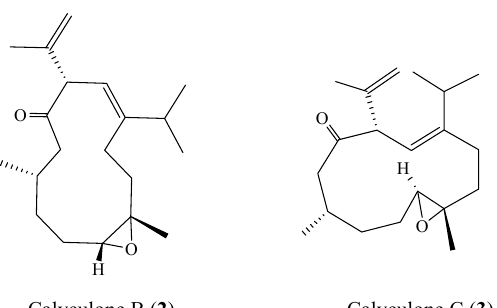
Figure 4. Structures of 2 and 3